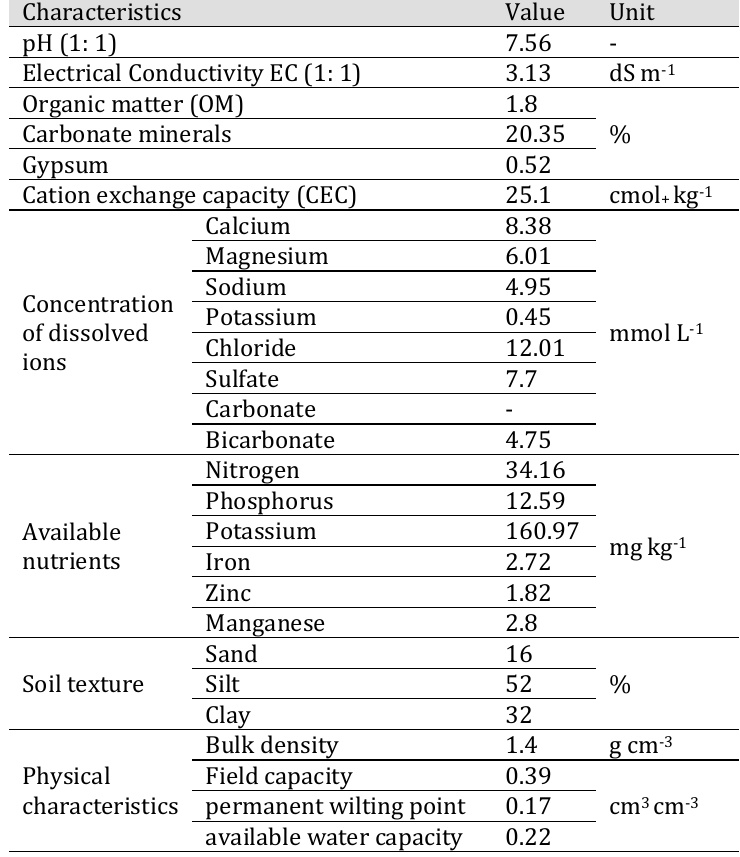
Table 1. The chemical and physical characteristics of the soil use d in the